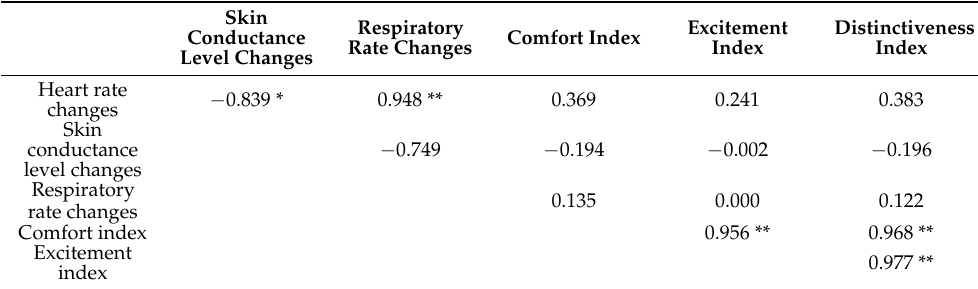
Table 5. The correlation between the physiological changes and psychological